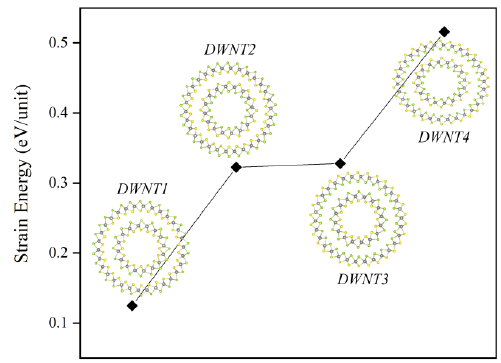
Figure 5. The atomic structures of WSSe double-wall nanotubes with different stacking patterns